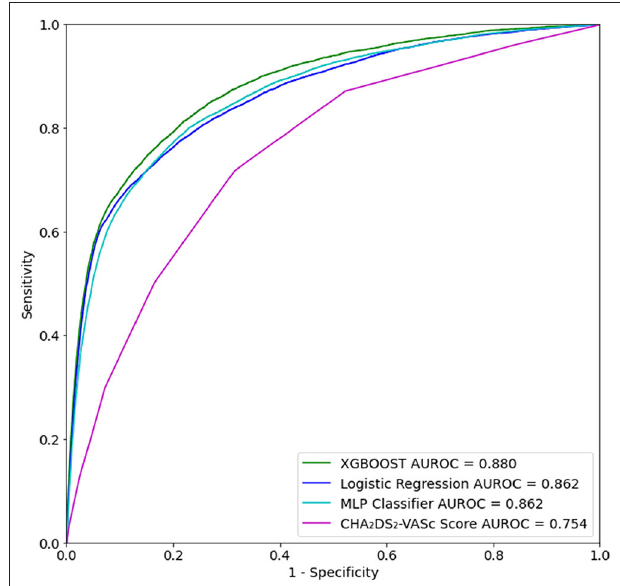
FIGURE 3 | Receiver operating characteristic (ROC) curve for prediction of ischemic stroke for up to 1 year after first inpatient encounter on the test set